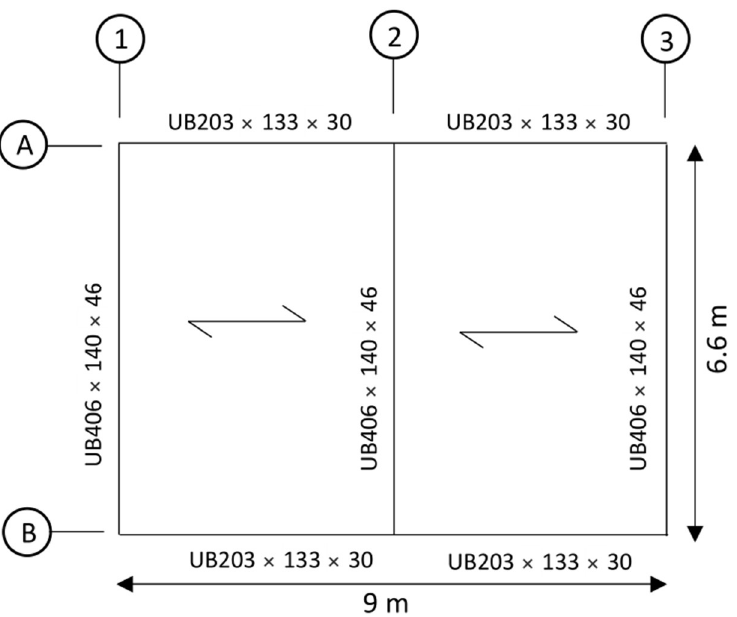
Figure 6. Plan of the CLT floor constructed at the University Centre Farnborough by Huang et al. [44]. Reproduced with permission. Table 6. The floor details and frequency results investigated by Huang et al. [44] (see Figure 6 for plan view of the floor).